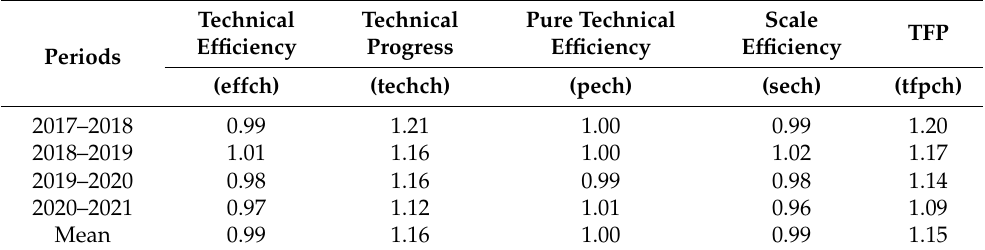
Table 8. Malmquist Index and its Decomposition of Chinese Green Buildings’ Implementation Efficiency during